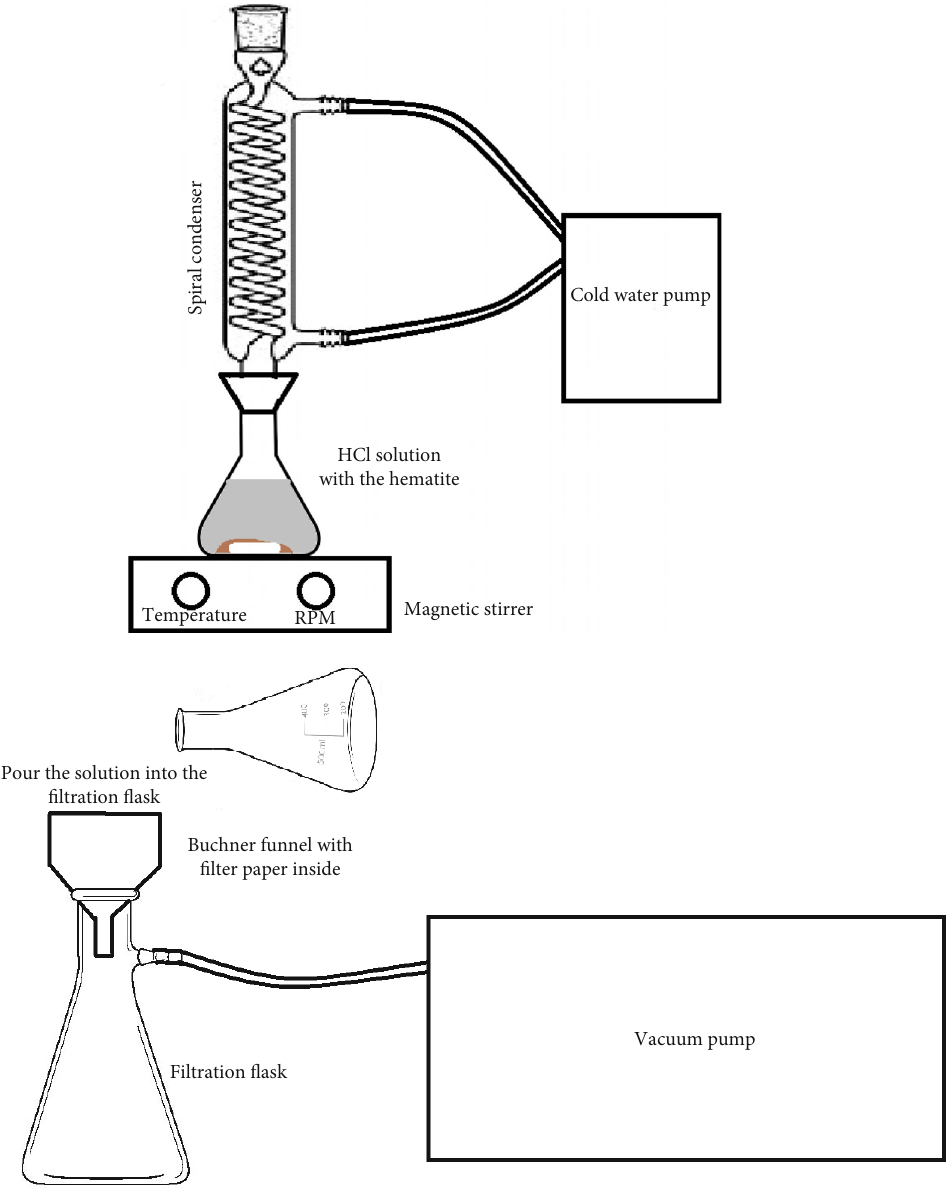
Figure 3: Solubility test